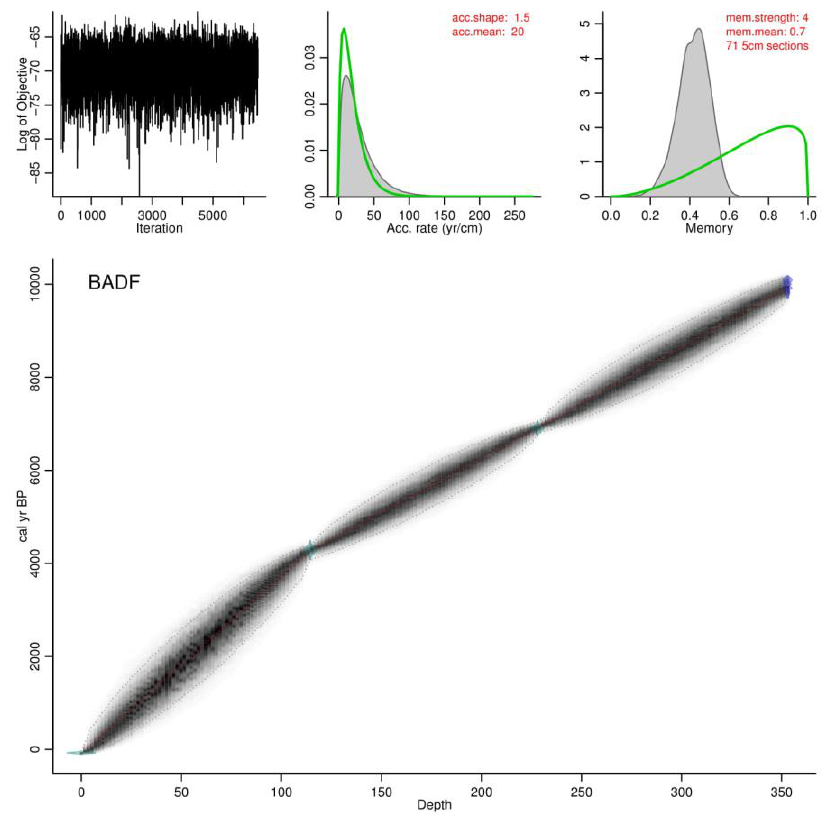
Figure A3a. Age-depth model produced in BACON for BADF.